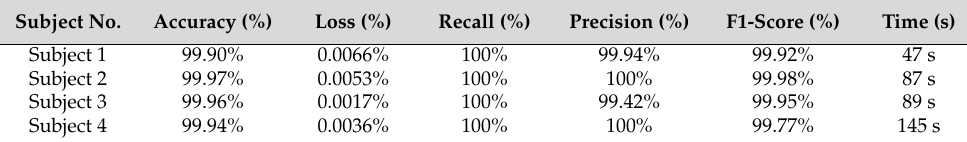
Table 6. Performance evaluation (different datasets with correlated ABPDias with HR sensors).